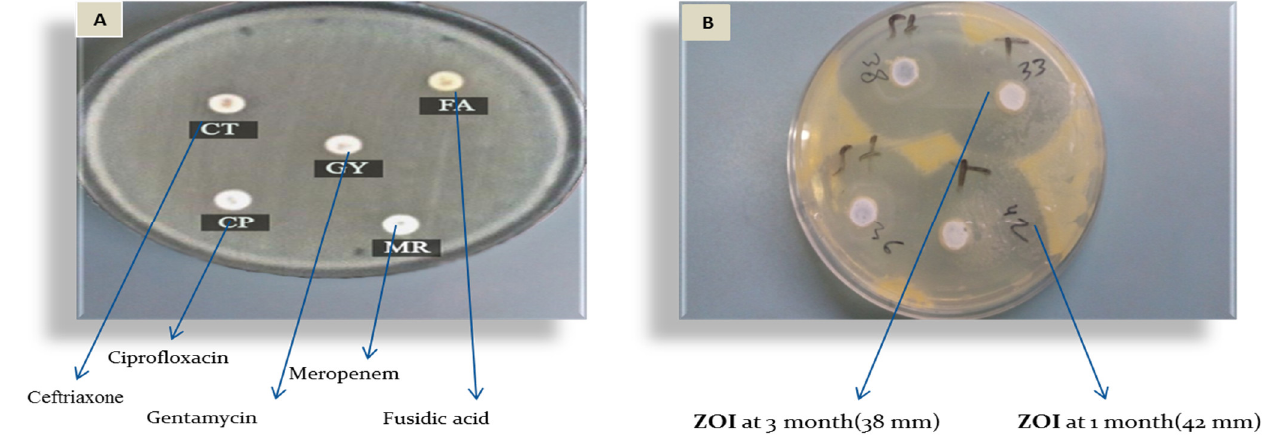
Figure 4. Antimicrobial susceptibility testing of S. aureus by disk diffusion method. ( A ): FRSA plate shows the resistance effect of different antimicrobial agents on S. aureus isolate to CT: ceftriaxone, FA: fusidic acid, GY: gentamycin, CP: ciprofloxacin, MR: meropenem. ( B ): FRSA plate F2 formula sensitive S. aureus shows the zone of inhibition more than 19 mm, T: at zero time, st: at the third